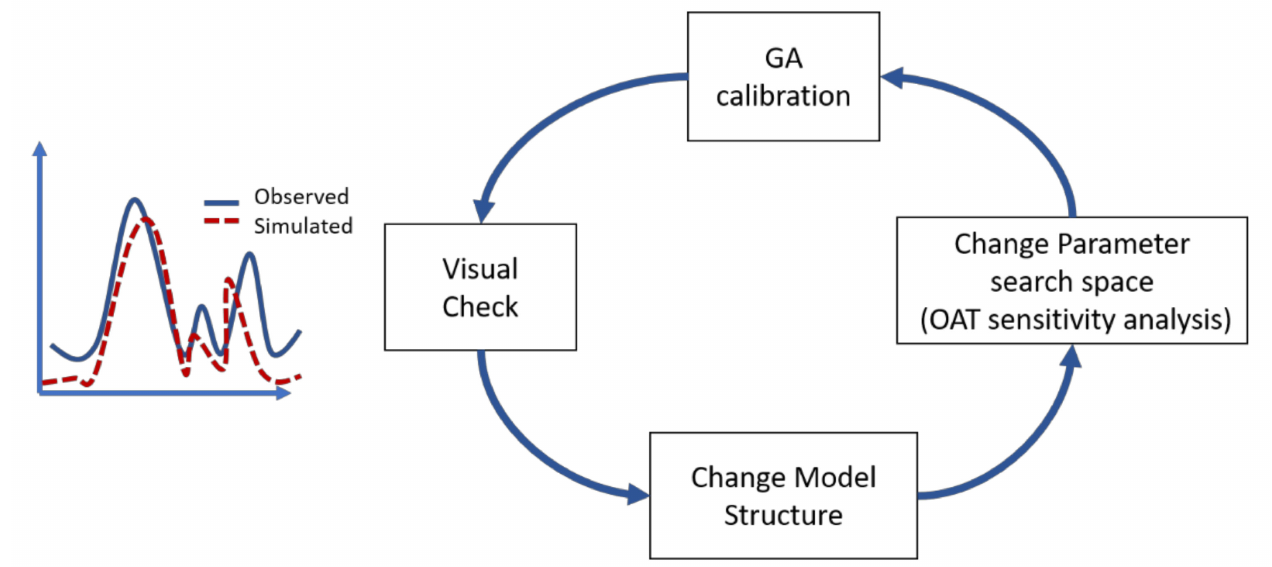
Figure 7. Iterative calibration